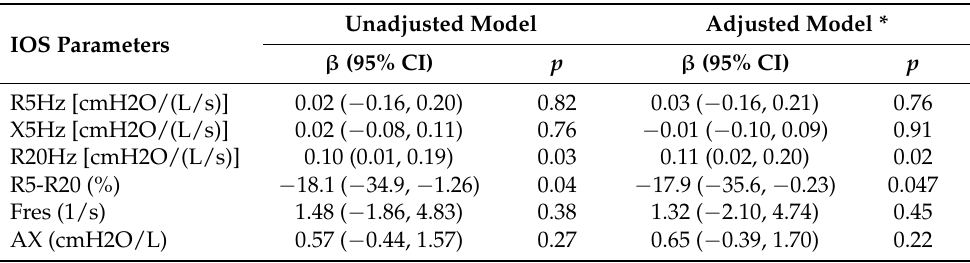
Table 3. Associations between nasopharyngeal microbiota (NPM) subphenotypes and impulse oscillometry (IOS).